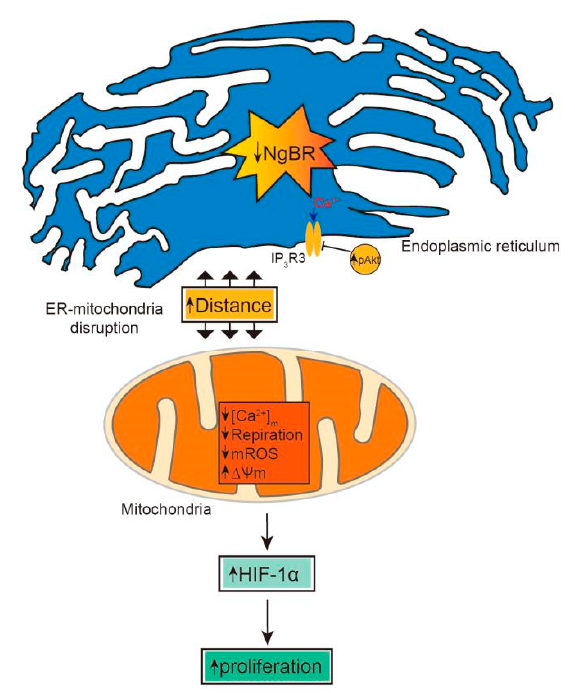
Figure 7. A schematic diagram showing how NgBR is involved in MAM-regulated VSMC proliferation. Downregulation of NgBR disrupts the mitochondria-ER unit and increases MAM-associated pAkt-IP 3 R3 signaling, resulting in the suppression of mitochondrial function. Consequently, mitochondria-induced HIF-1 α signaling is activated to stimulate cell proliferation.